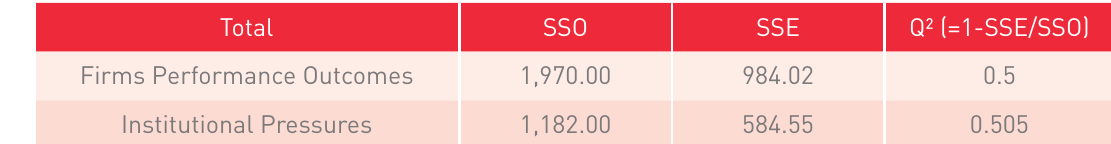
Construct Cross validated